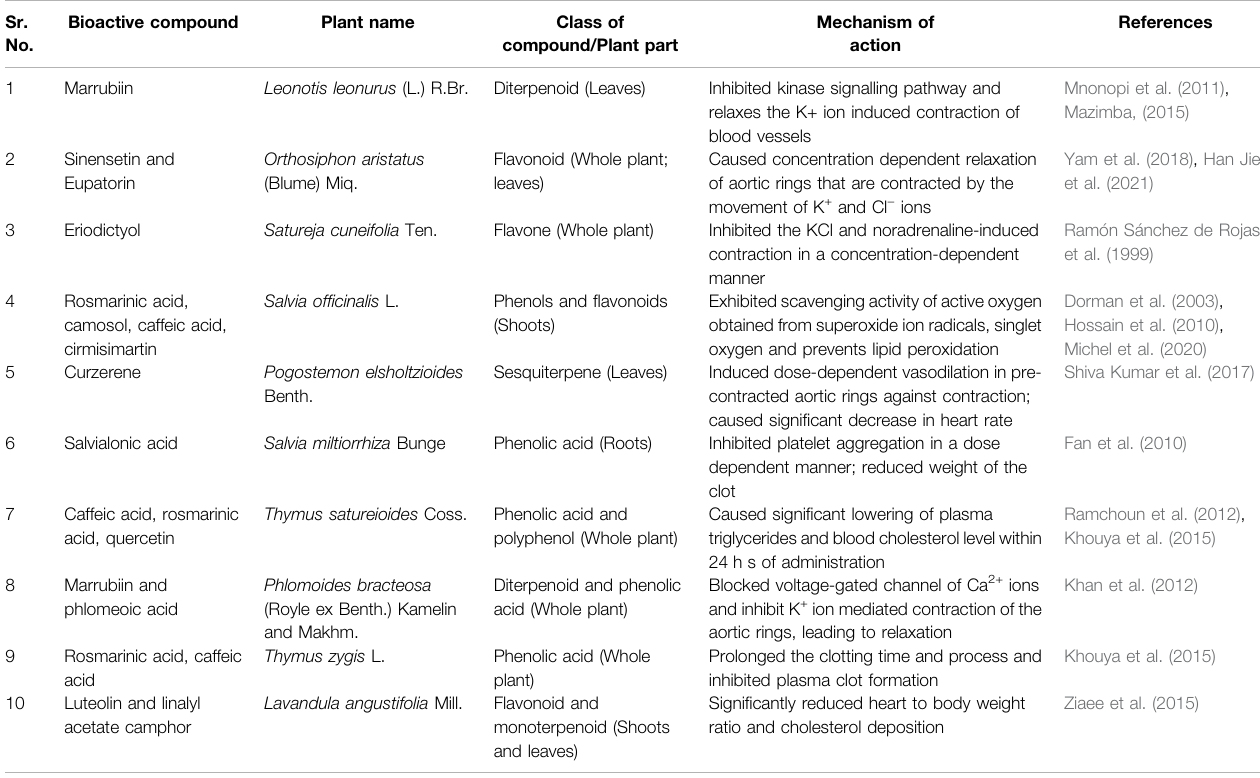
TABLE 2 | Biological ef fi cacy of bioactive compounds from different species of Lamiaceae. Sr.